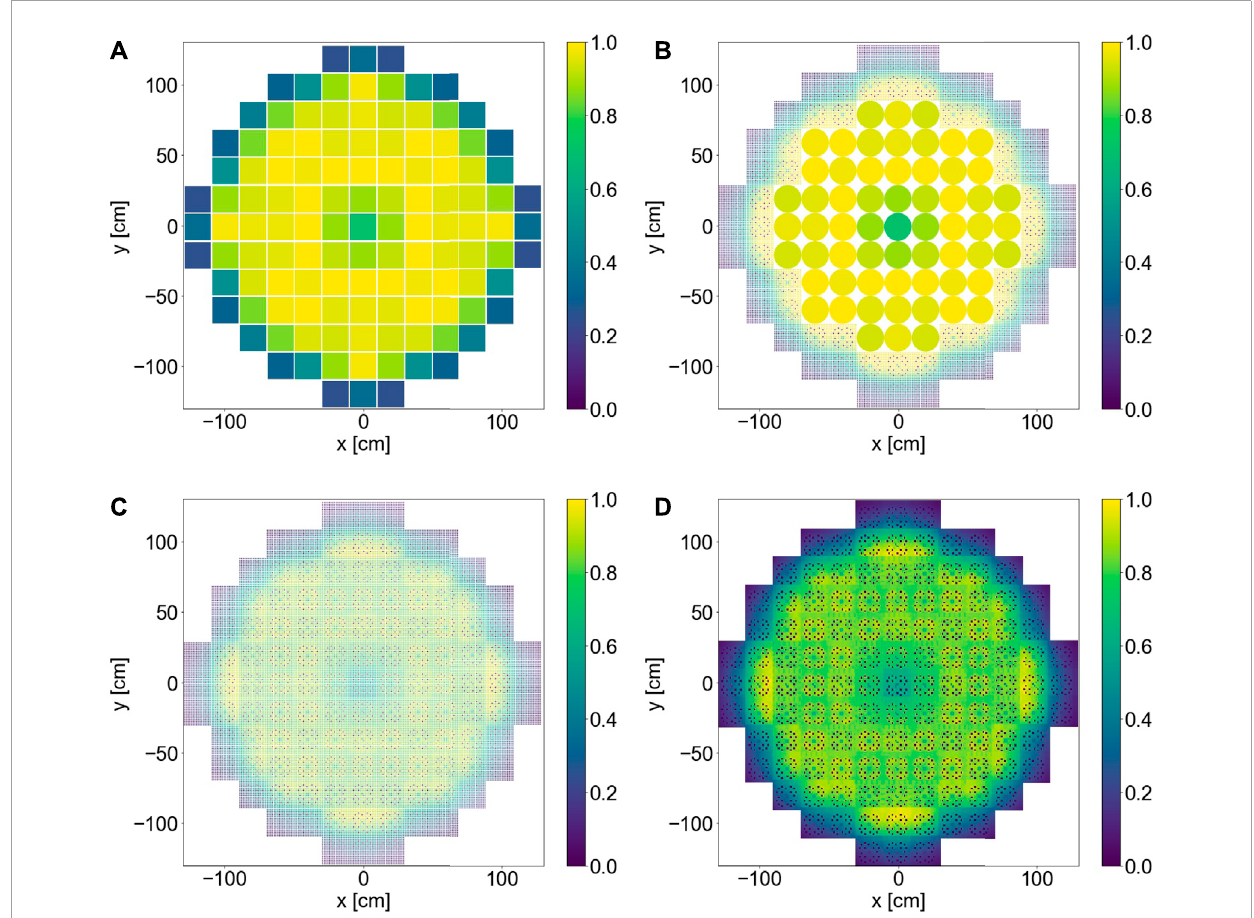
FIGURE 4 Different neutron sources normalized to the maximum value. Fission neutron source strength is presented in colors, ranging from high values in yellow to low values in blue. (A) Homogenized cuboids on FA scale (Source A). (B) Homogenized cylinders on FA scale for inner FAs and pin-wise cylinders for 2 FA rows at core periphery (Source B). (C) Cylinders on pin-wise scale (Source C). (D) Neutron source from criticality calculation.